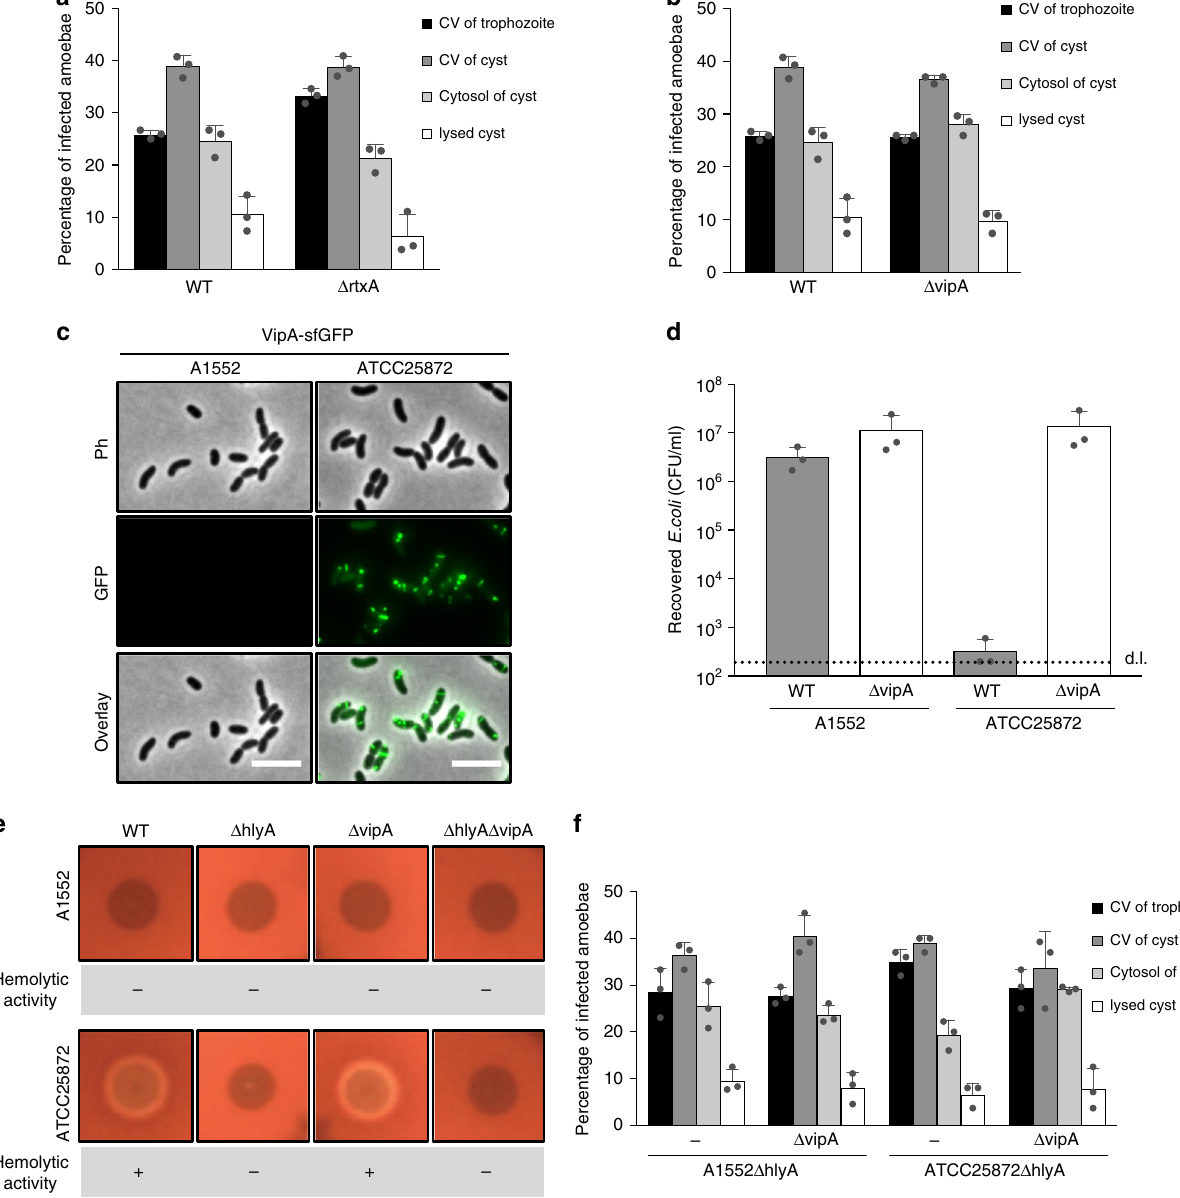
Fig. 4 The pore-forming toxins RTX and VasX do not intoxicate A. castellanii . Distribution of V. cholerae wild-type (WT) and a rtxA -de fi cient mutant strain ( a ) or WT and a strain with an impaired type VI secretion system (T6SS) ( Δ vipA; de fi cient for VasX secretion) ( b ) within infected A. castellanii at 20 h p.p.c. The considered compartments were the CV of trophozoites, the CV of cysts, and the cytosol of cysts before and after lysis. Values represent averages from three independent experiments (±s.d., as shown by the error bars). c , d The type VI secretion system of toxigenic strain ATCC25872 is constitutively on. c V. cholerae strains A1552 (O1 El Tor; pandemic) and ATCC25872 (O37; non-pandemic) carrying a gene that encodes a translational fusion between the T6SS sheath protein VipA and sfGFP ( vipA-sfgfp ) at the native locus of vipA were grown for 3.5 h in LB. The images depict cells visualized in the phase contrast (Ph), in the green (GFP) channel, and an overlay of both channels. Scale bar: 5 μ m. d The constitutive T6SS activity of strain ATCC25872 was con fi rmed in an interspecies killing assay in which E. coli served as prey. Prey survival was assessed by counts of colony-forming units (CFUs) after plating on selective medium. Values represent average from three independent experiments (±s.d.). e Hemolysin-based hemolytic activity might mask effects of the T6SS in ATCC25872. V. cholerae A1552 and ATCC25872 as well as their Δ hlyA, Δ vipA, and Δ hlyA Δ vipA variants were tested for hemolytic activity on blood agar plates. f Mutant V. cholerae A1552 and ATCC25872 strains lacking hemolysin ( Δ hlyA) or hemolysin and the T6SS core protein VipA ( Δ hlyA Δ vipA) were assessed for their intra-amoebal localization at 20 h p.p.c. as described for a . Values are averages from three independent biological